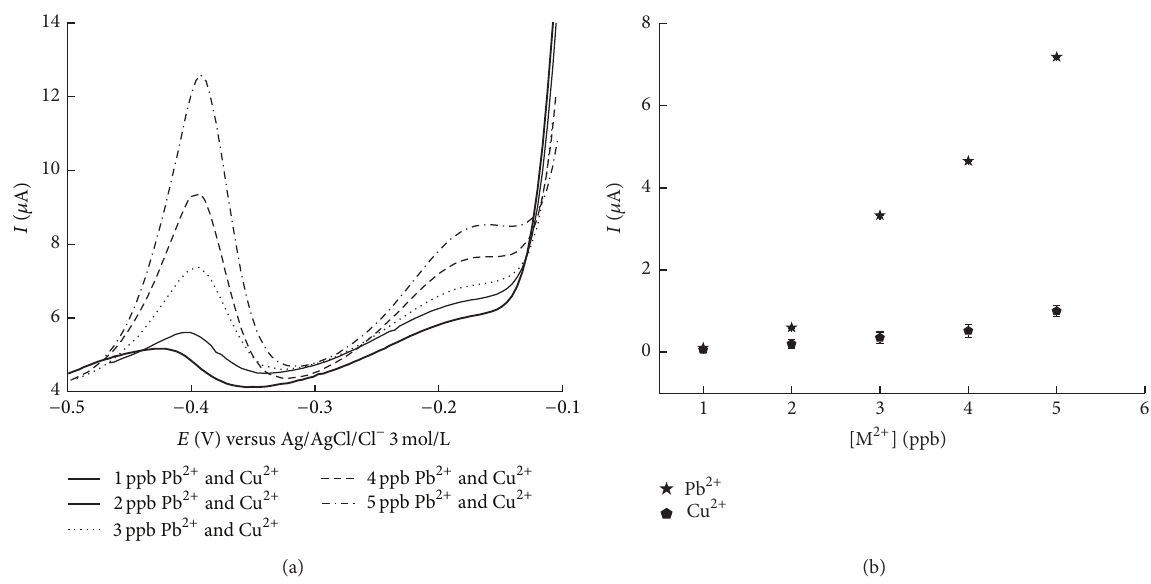
Figure 4: Simultaneous determination of Pb 2+ and Cu 2+ ions by DPASV on GC/CNT/nanoAu-SiO 2 . (a) Voltammogram. (b) Analytical calibration curve, for Pb 2+ , 𝑟 = 0.9827 , 𝐼 = −2.2917 + 1.8224 [Pb 2+ ], and for Cu 2+ , 𝑟 = 0.9571 , 𝐼 = −0.2395 + 0.2215 [Cu 2+